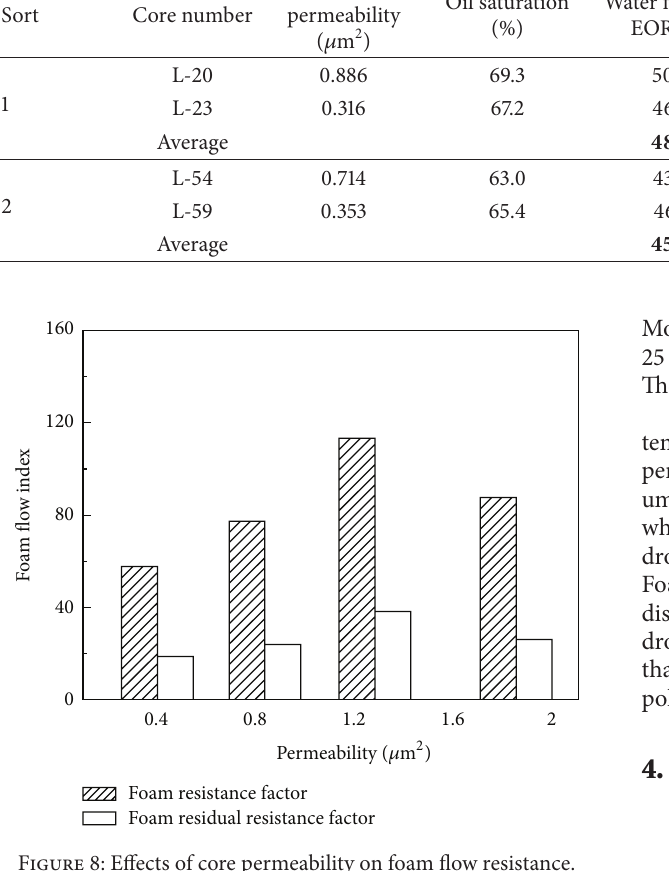
Figure 8: Effects of core permeability on foam flow